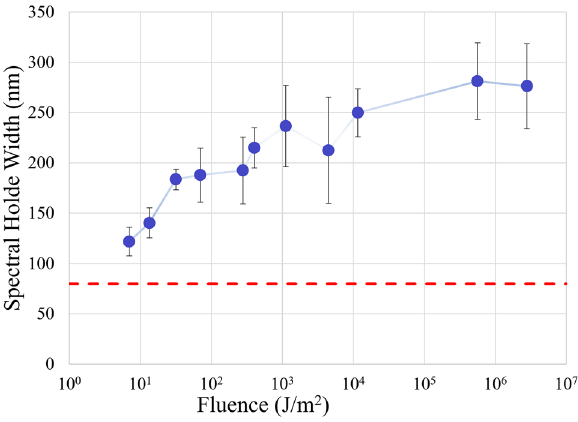
Figure 7. Laser fluence vs. hole burning spectral width in logarithm coordinate. Dots represent experimental data and the lines are simple connections between two nearest data points. Dashed line indicates natural resonance width at a low light intensity.